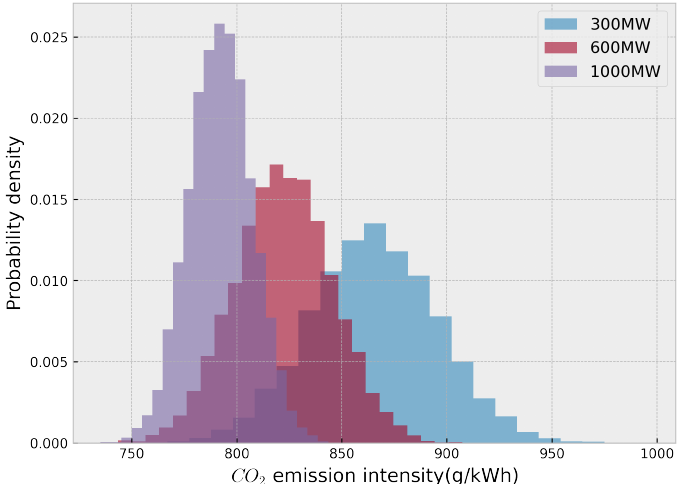
Figure 5. Distribution of CO 2 emission intensity for various unit capacities.